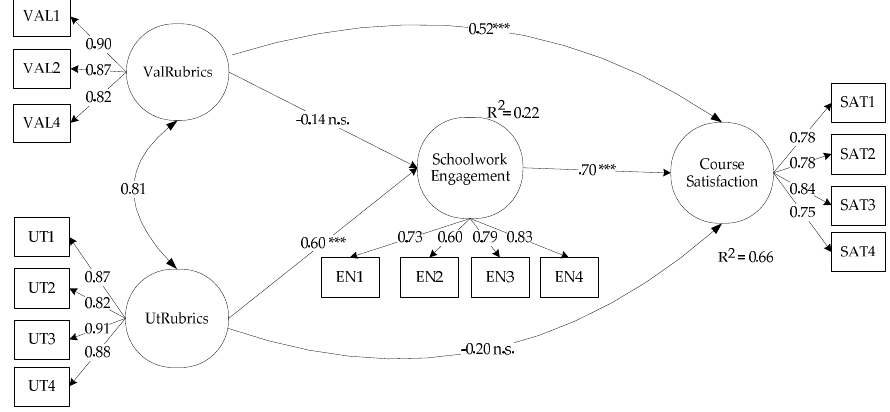
Figure 2. Standardized parameter estimates in the model.Item parceling was used for the latent variables of rubrics’ validity (ValRubrics), rubrics’ usefulness (UtRubrics), Schoolwork engage- ment, and Course satisfaction, with parcels made with adjacent items; all parameter estimates were statistically significant (*** p < 0.001), unless otherwise (ns = non-significant) stated.